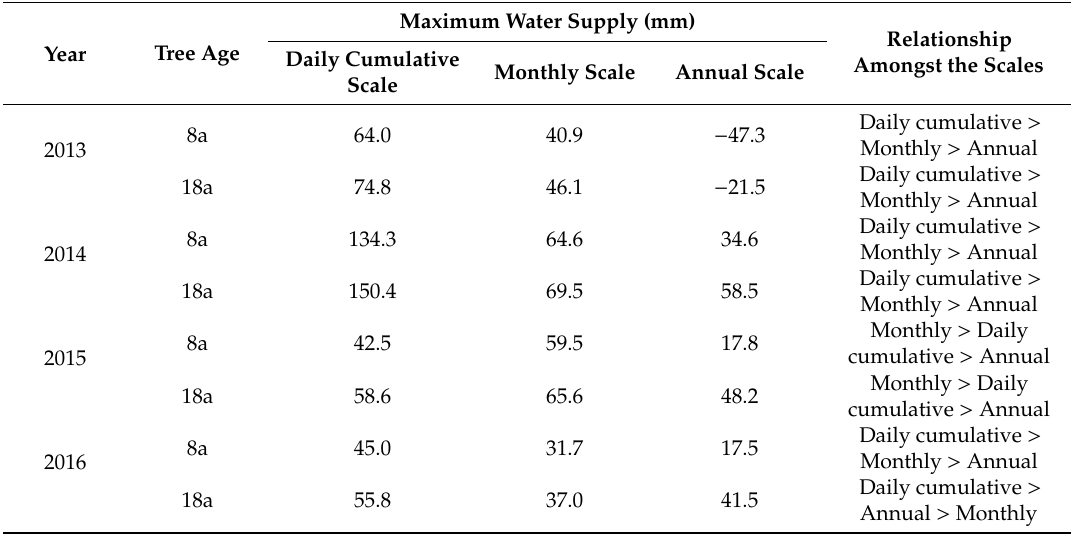
Table 2. Comparison of maximum supplies of water from soil reservoirs in the 8- and 18-year-old apple orchards (8a and 18a, respectively) at di ff erent scales in 2013, 2014, 2015, and